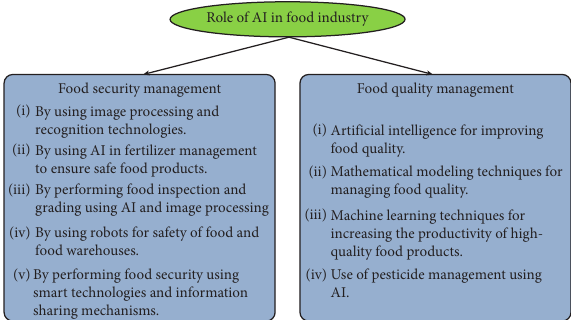
Figure 1: Role of AI in food industry.